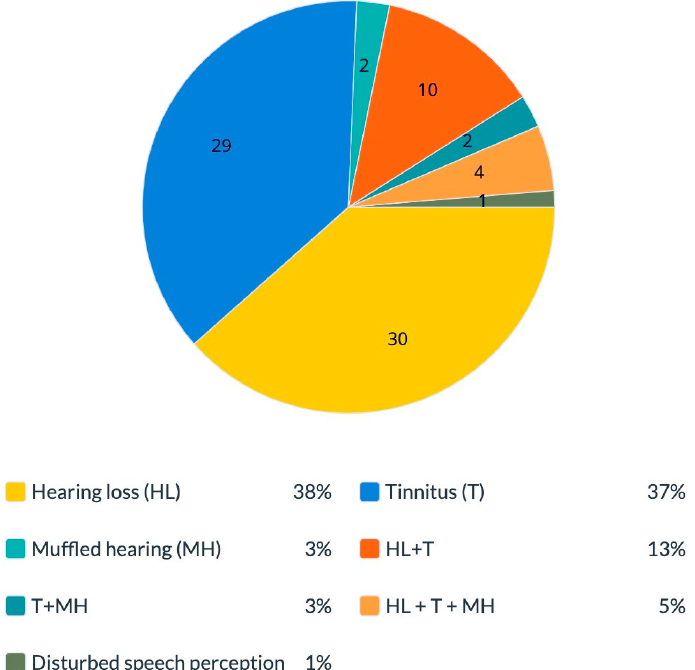
hearing loss and 20 (40%) reported tinnitus. In addition, one (2%) reported muffled hear- ing, seven (14%) reported hearing loss combined with tinnitus, one (2%) reported tinnitus combined with muffled hearing, four (8%) reported a combination of the three complaints (hearing loss, tinnitus and muffled hearing) and one (2%) had “disturbed speech percep- tion with multiple speakers” (Figure 2). Figure 1. Hearing manifestations in women with silicone breast implants. The percentage of different hearing complaints among symptomatic women who complained of hearing impairments. Total 100% is equal to n = 78 subjects. HL—hearing loss; T—tinnitus; MH—muffled hearing. As noted above, 85 patients underwent implant removal. Out of the 80 women who reported hearing impairments, 52 underwent implant removal (65%). Of the 44 (61.3%) women who complained of hearing loss, 27 underwent the surgical removal of their implants. Out of the 27 women whose implants had been removed, 9 (33.3%) reported improvement in or recovery from hearing loss, and 16 (59.2%) reported a lack of improvement. For two (7.4%) women, we were unable to obtain this information.